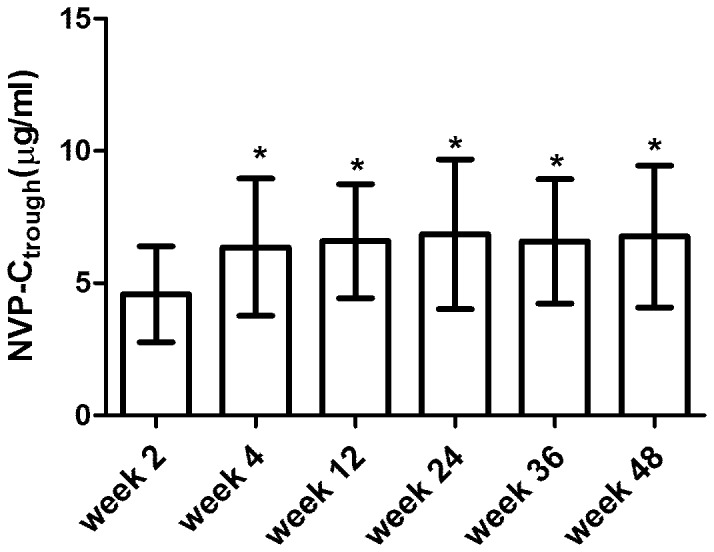
Comparison of nevirapine trough concentration in 105 patients with HIV infection.Analysis of variance was utilized to evaluate nevirapine trough concentration in 105 HIV+ patients with 6 consecutive points during follow-up 48 weeks (P<0.05).